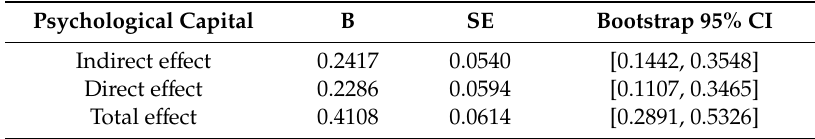
Table 5. Verifying the bootstrapping mediation e ff